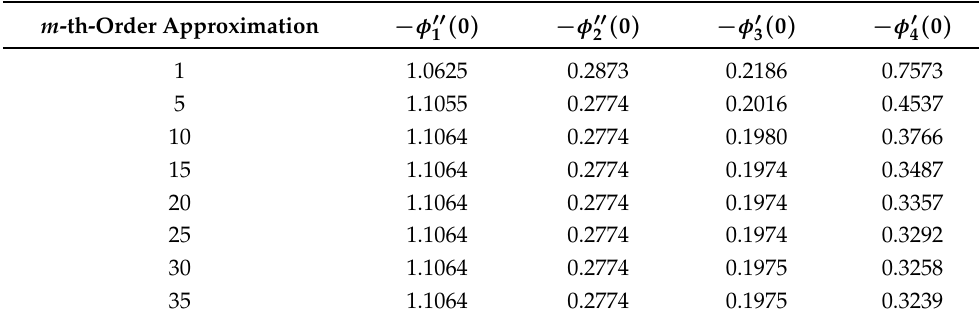
( 0 ) , − φ (cid:48)(cid:48) ( 0 ) , − φ (cid:48) ( 0 ) , and − φ (cid:48) 2 3 1